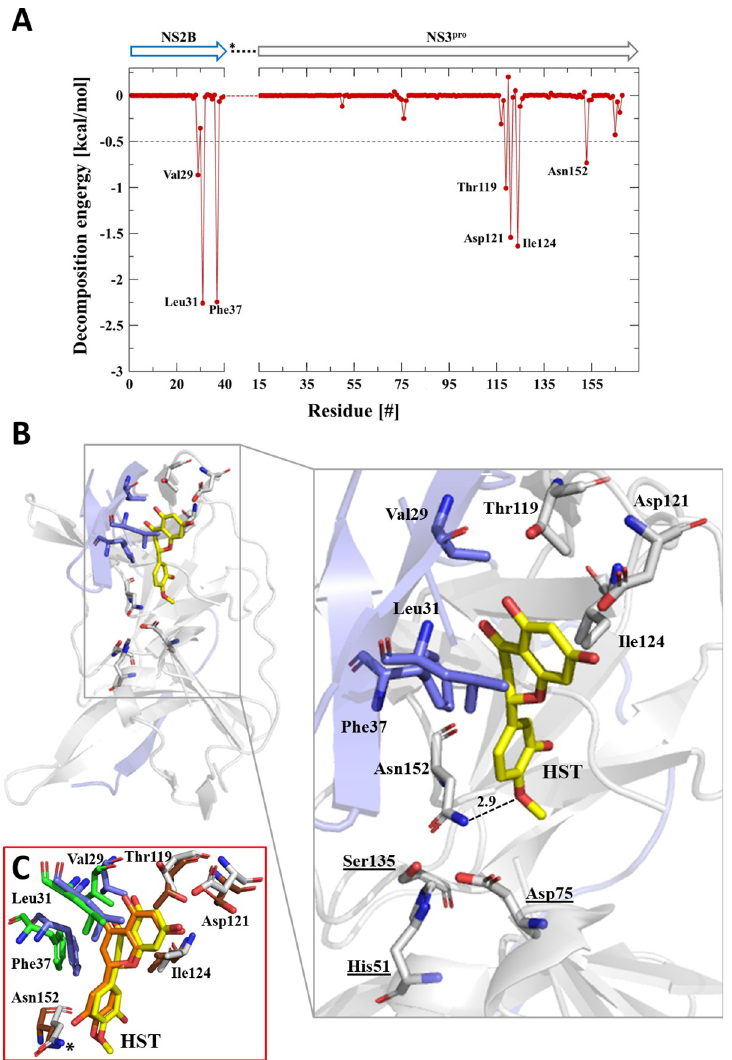
Fig 5. Amino acids participating in the ZIKV NS2B/NS3 pro -HST interaction. A: Decomposition of the binding energy of ZIKV NS2B/NS3 pro -HST complex. Arrows label NS2B (blue) and NS3 pro (gray). The residues involved in the interaction between protease and HST are labeled. B: 3D structure of ZIKV NS2B/NS3 pro (PDB entry: 5LC0), the NS3 pro domain is colored in gray and NS2B in blue. Amino acids highlighted are involved in the interaction with HST (yellow) based on MD simulations. The H-bond between Asn152 and HST is highlighted. C: Structural overlay of the representative complex structures of two independent MD runs (RMSD: 1.475 Å ). Run1: NS2B (blue) and NS3 pro (gray) and run2: NS2B (green) and NS3 pro (brown). The binding region of HST is highlighted, the involved amino acids and HST position are the same between run1 and run2. The distance between Asn152 and HST differs slightly between MD run1 and run2 (2.9 to 2.8 Å